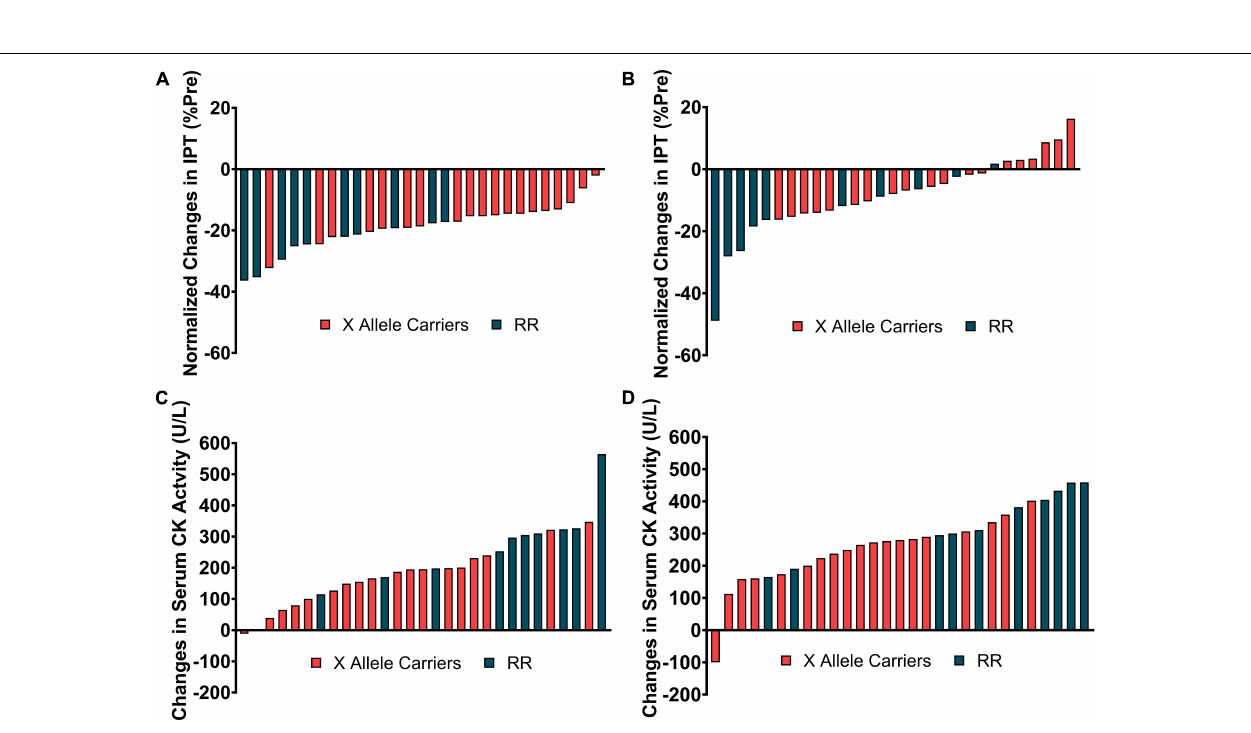
FIGURE 4 | The individual changes in isometric peak torque (IPT) immediately (A) and 4-days (B) post-downhill running and in serum creatine kinase (CK) activity 2- (C) , and 4-days (D) post-downhill running discriminated by ACTN3 genotype.